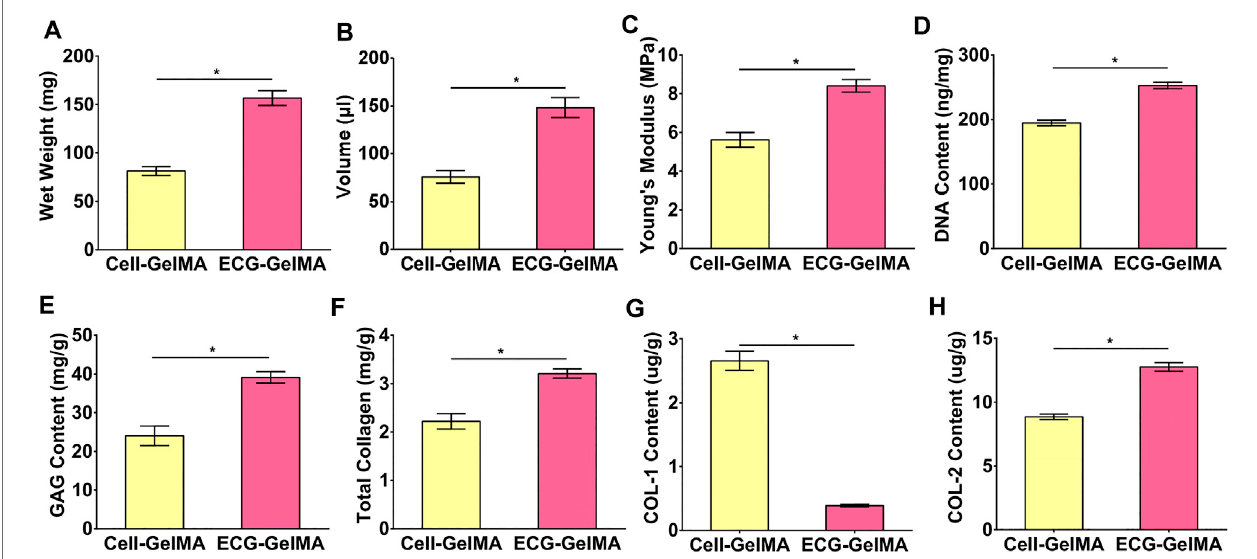
FIGURE5| QuantitativeanalysisoftheregeneratedcartilageinCell-GelMA andECG-GelMAgroupsafter8weeksimplantationinnudemice.Quantitative analysis ofwetweight (A) ,volume (B) ,Young ’ smodulus (C) ,DNAcontent (D) ,GAGcontent (E) ,totalcollagen (F) ,COL-1content (G) ,andCOL-2content (H) inCell-GelMAand ECG-GelMA groups. * p <